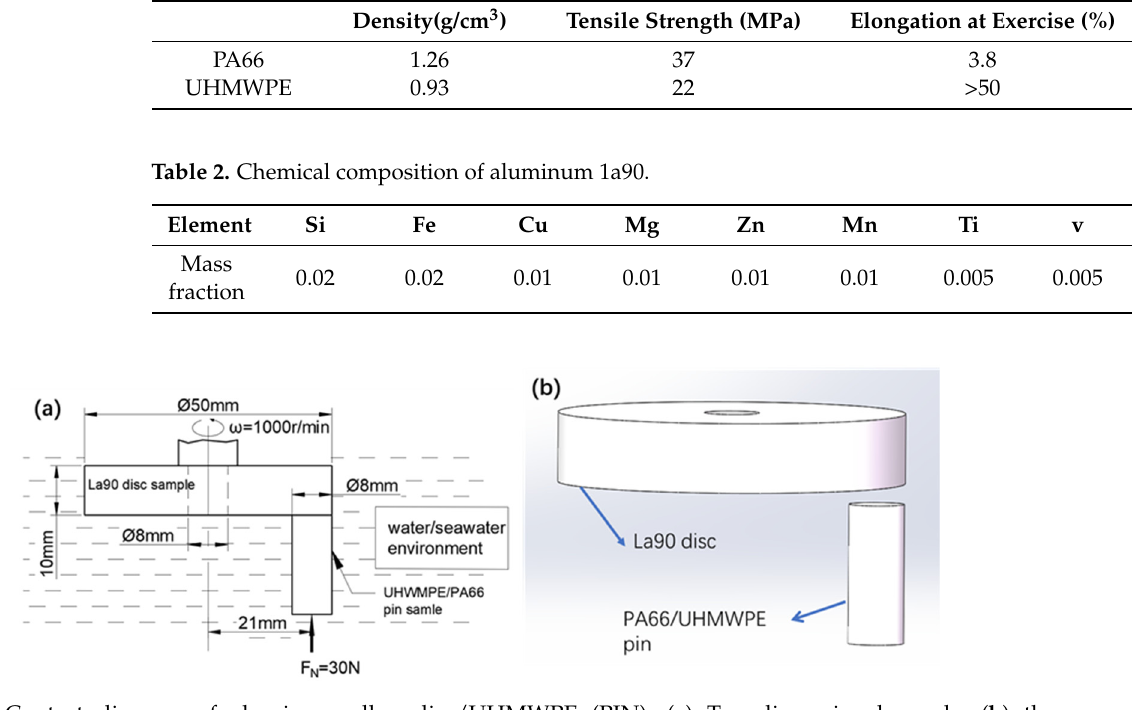
Table 3. The composition of artificial seawater.